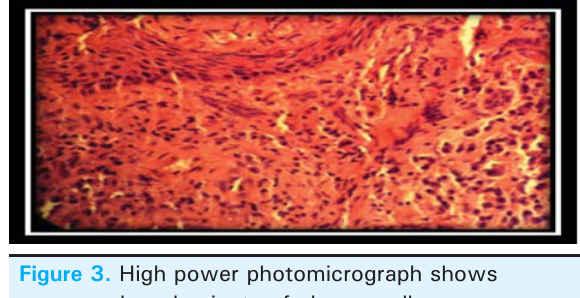
Figure 3. High power photomicrograph shows composed predominate of plasma cells